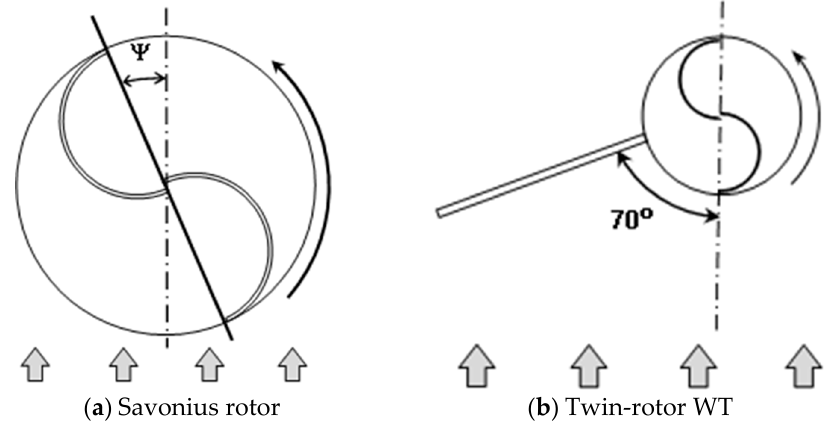
Figure 13. Rotor location at maximum torque point.